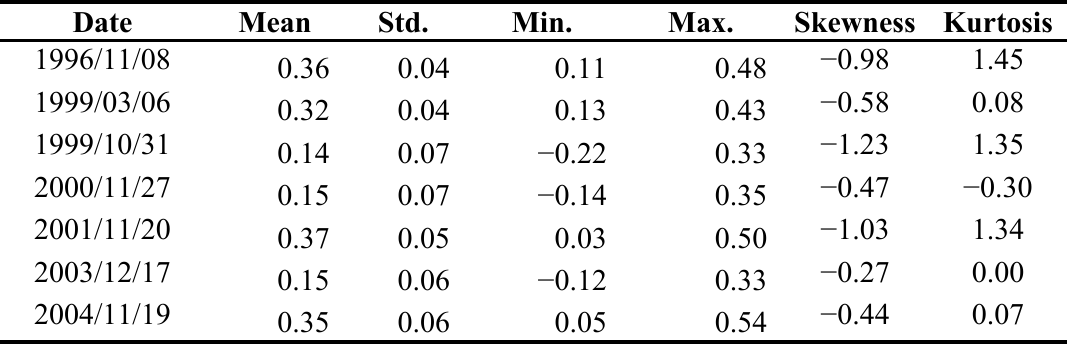
Table 2. Statistics of NDVI